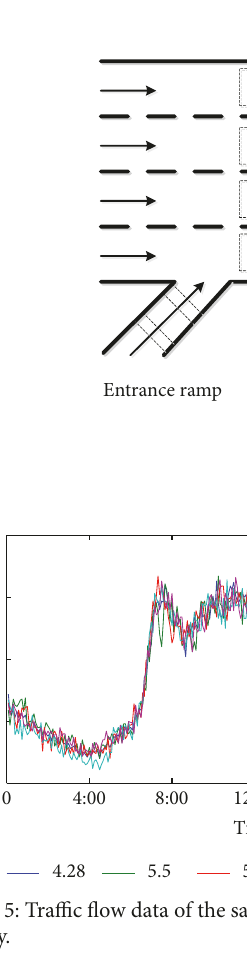
Figure 3: Graph of the experiment area.